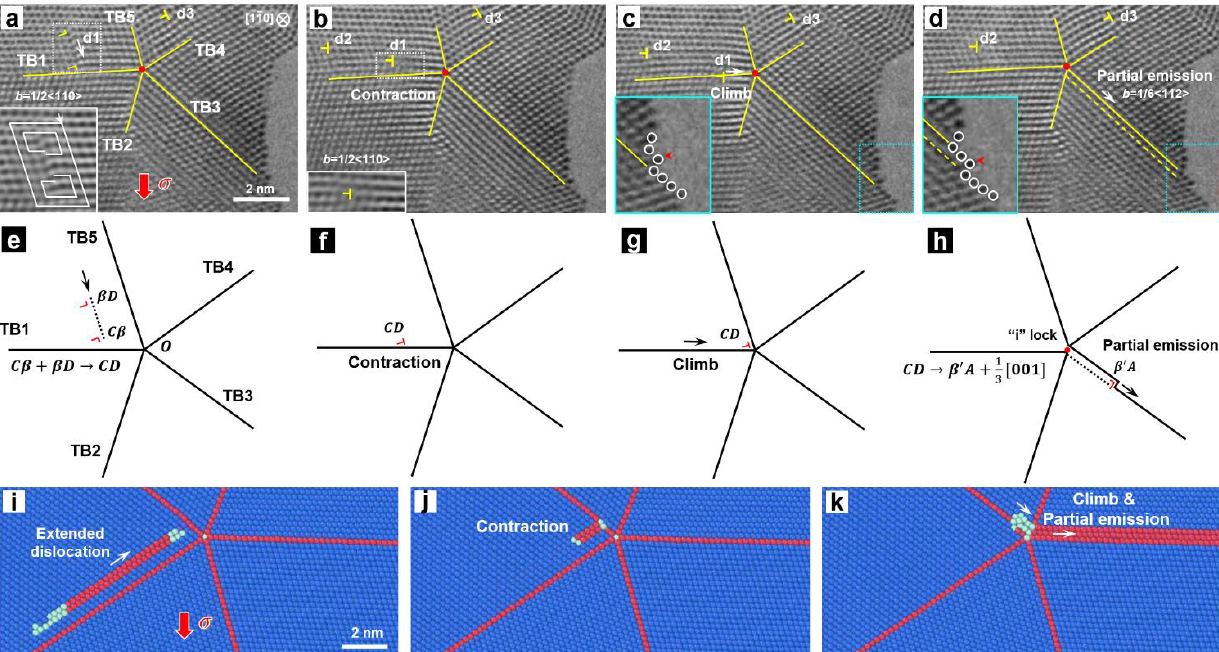
Figure 4. Dislocation annihilation/absorption at the penta-twin core via dislocation climb. ( a – d ) Sequential TEM snapshots showing dislocation annihilation at the core of a penta-twin. ( a , b ) A full dislocation (d1) contracts it dissociated length when approaching TB1 of the penta-twin. Insets in ( a , b ) show the dissociated and compacted structures of this propagating dislocation, respectively. Note that some dislocations are irrelevant to our analyses (such as later-nucleated d2 and pre-existed immobile d3). ( b , c ) Dislocation climbs along TB1 toward the penta-twin core. ( c , d ) Dislocation annihilates at the penta-twin core, which further stimulates partial emission from the core along TB3. Insets in ( c , d ) show the variation of atoms at free surface due to partial emission from the penta-twin core. ( e – h ) Schematic illustrations presenting the corresponding mechanisms of dislocation behaviors in ( a – d ), respectively. ( i – k ) MD simulations showing similar dislocation annihilation at the penta-twin core. Atoms with FCC, HCP and disordered structures were marked in blue, red and cyan, respectively.